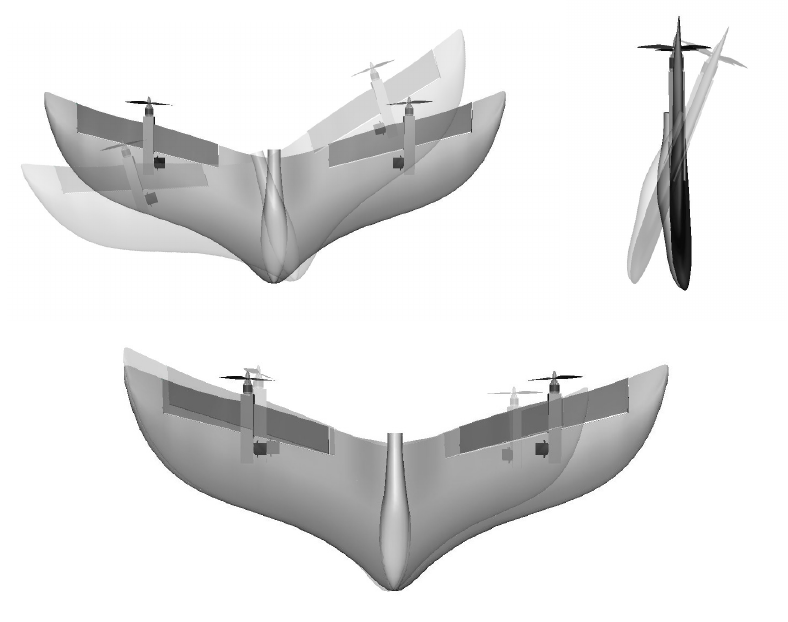
Figure 3. Roll, pitch and yaw motions.